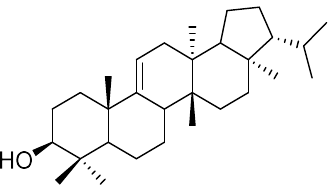
Figure 5. Chemical structure of compound; Fernenol from D3A.